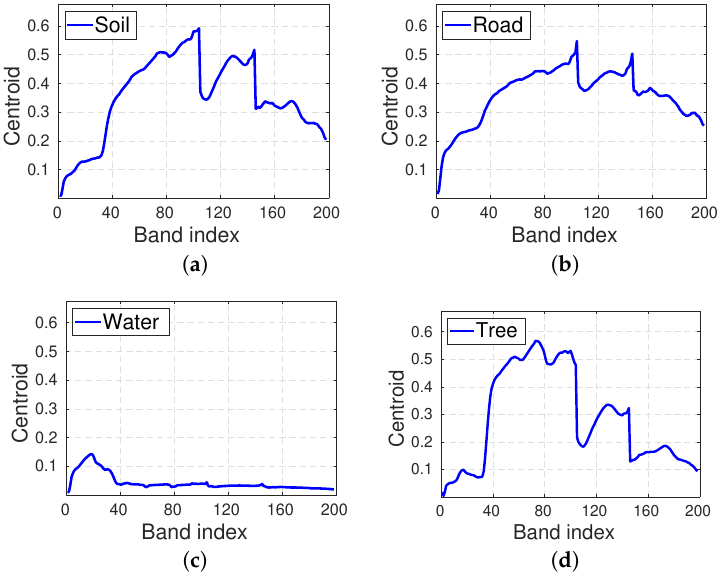
Figure 7. Cluster centroids of the partition of Jasper Ridge with (cid:98) K = 4 clusters: ( a ) centroid of Soil; ( b ) centroid of Road; ( c ) centroid of Water; ( d ) centroid of